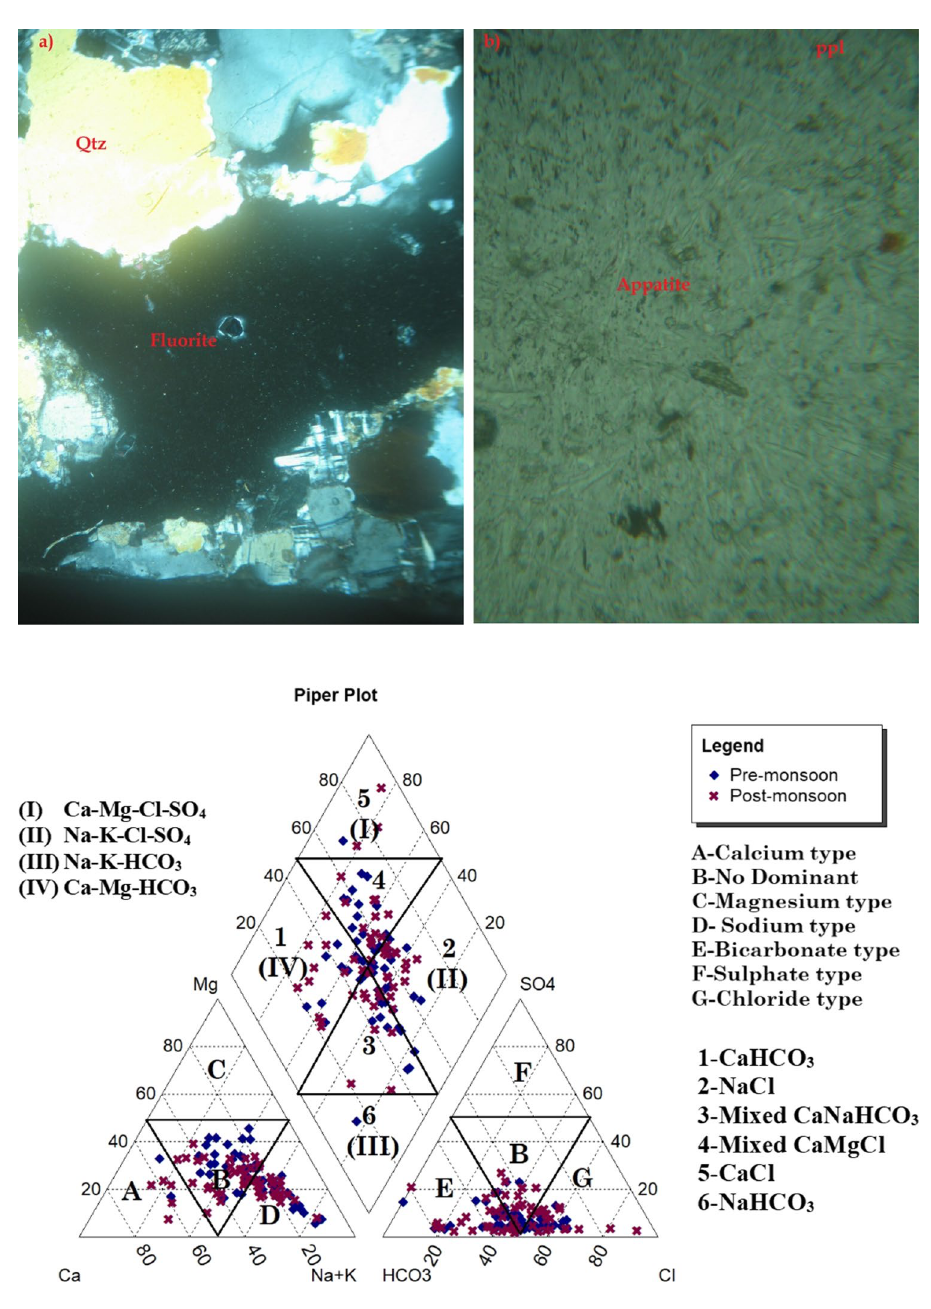
Fig. 9 Microphotographs of ( a ) Coarse-grained fluorite mineral associated with quartz and feldspars; and ( b ) altered apatite in-plane polarised light